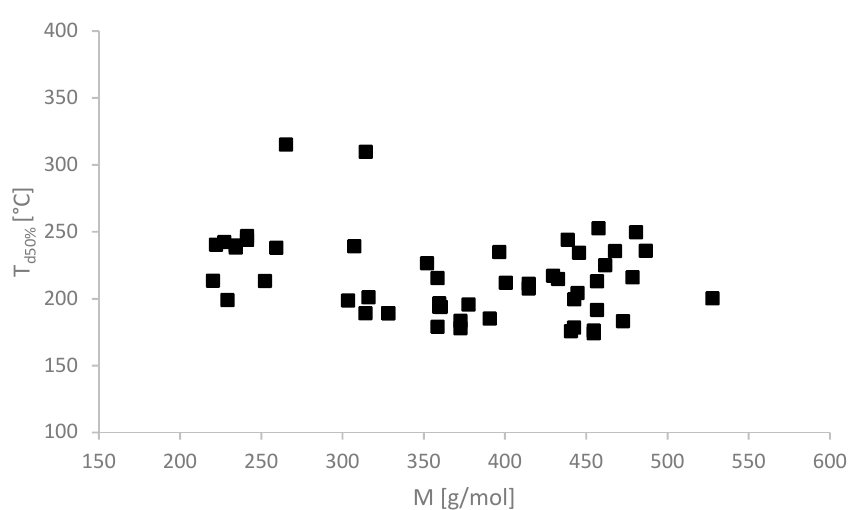
Figure 12. Plot of (T d50% ) weight loss temperature vs. molar mass for the compound studied.